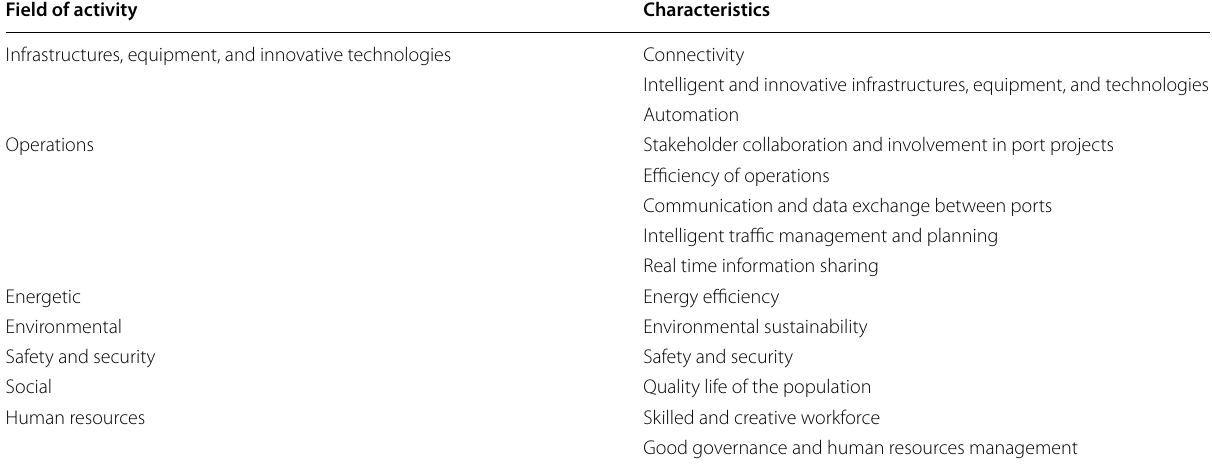
Table 6 Business areas and associated smart port characteristics Field of